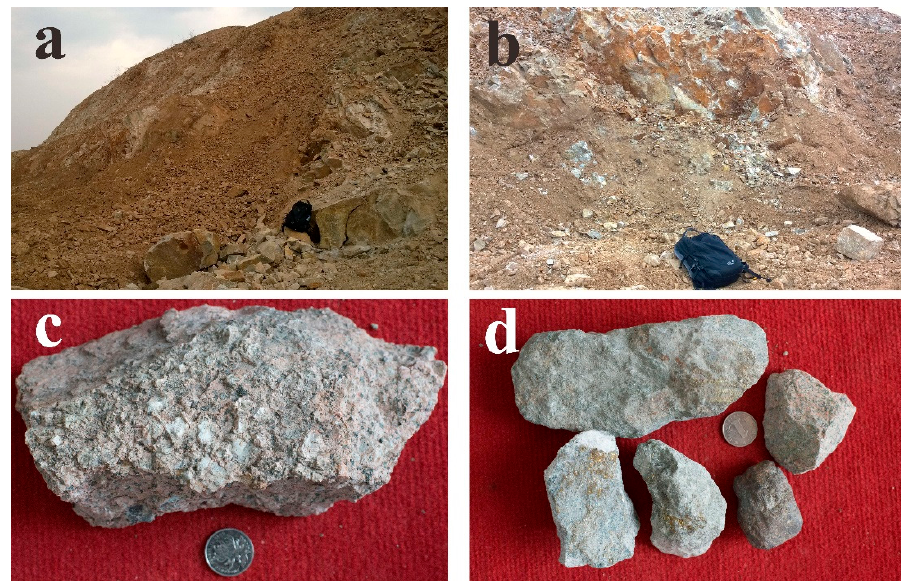
Figure 2. Field photos of the Yueshan ( a ) and the Zongpu intrusions ( b ); hand specimens of the Dalongshan quartz granite porphyry ( c ) and the Yueshan quartz diorite and ores ( d ).